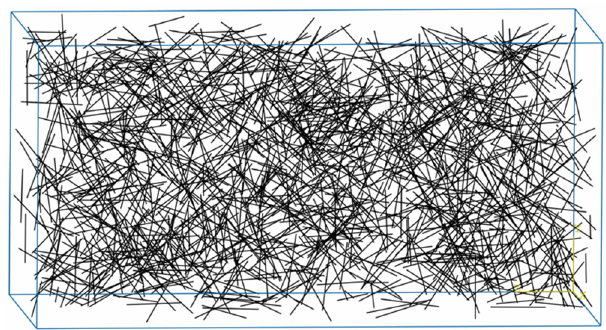
Figure 13. Perspective view of the SFRC model.